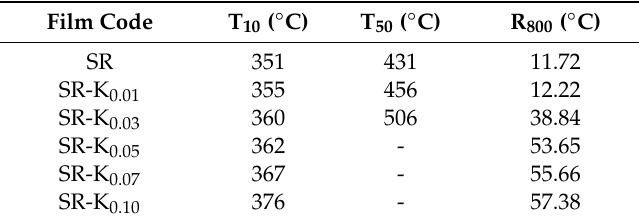
Table 3. Comparison of TGA data of unfilled SR with SR-K